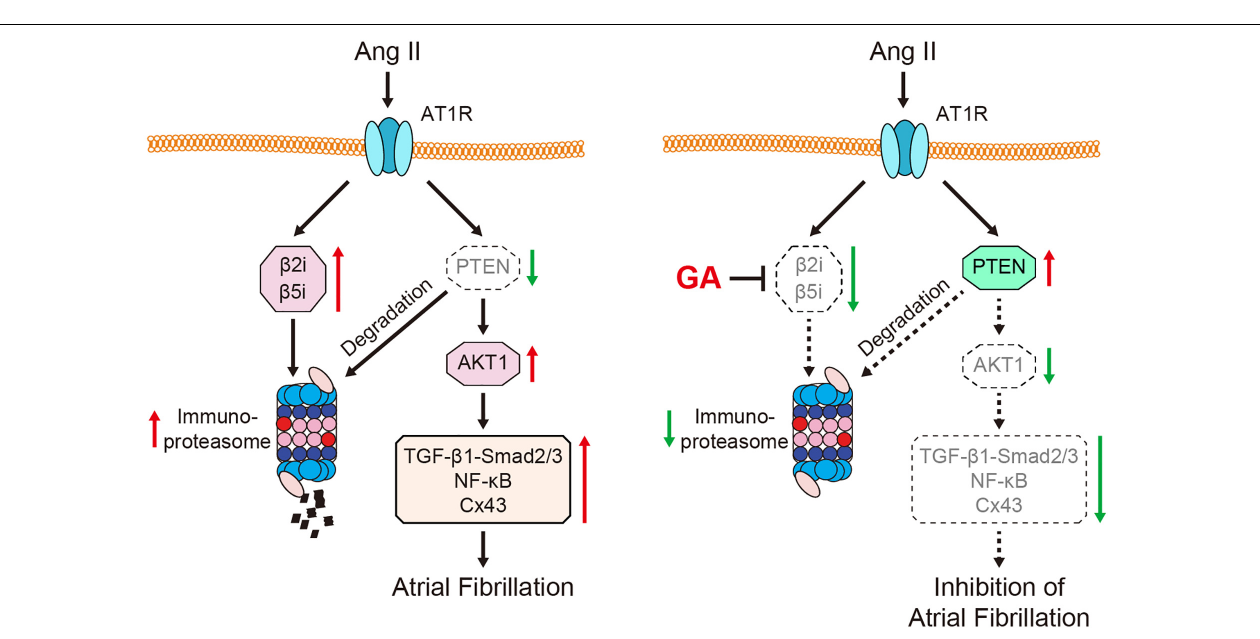
FIGURE 7 | A schematic model of the GA-mediated cardioprotection in Ang II-induced AF. GA inactivates immunoproteasome-dependent degradation of PTEN, leading to the downregulation of AKT1, TGF- β 1-Smad2/3, NF- κ B p65, and Cx43 signaling mediators. Therefore, GA ameliorates atrial remodeling and AF induced by Ang II